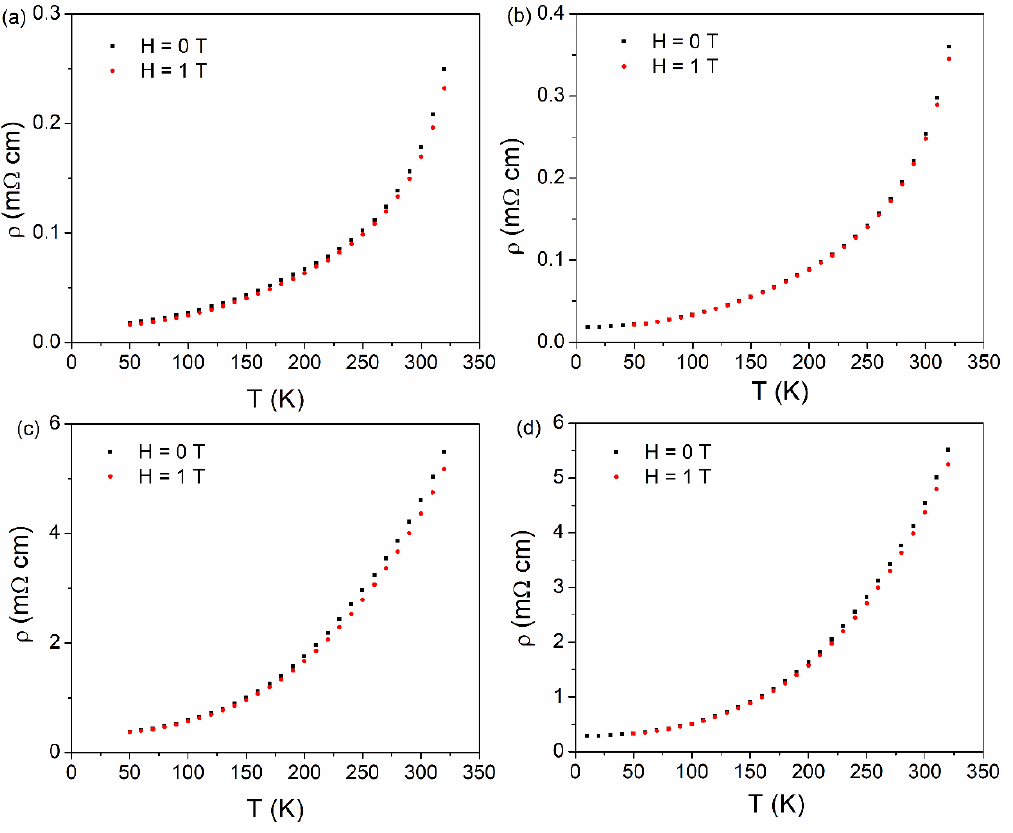
Figure 6. Resistivity as a function of temperature of the samples: LSMO 30 ( a , b ) and LSMO 60 ( c , d ) collected in parallel ( a , c ) and perpendicular ( b , d ) geometry.